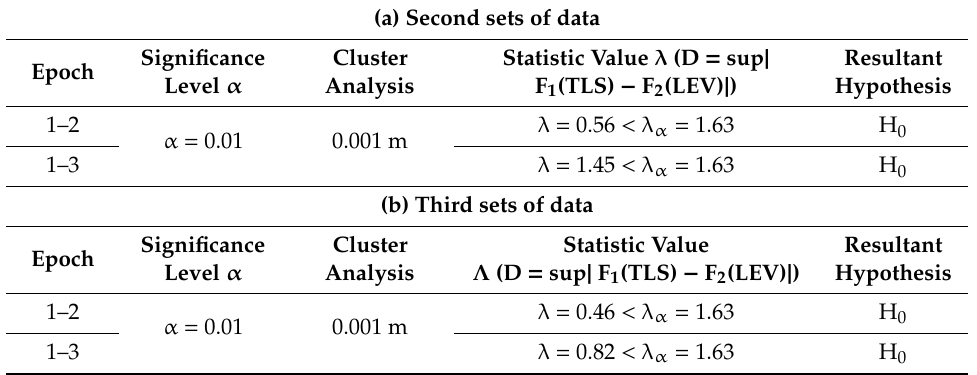
Table 10. Two-sample K-S test results TLS vs. TACH, Case study 3; ( a ) Second set of data; ( b ) Third set of data.